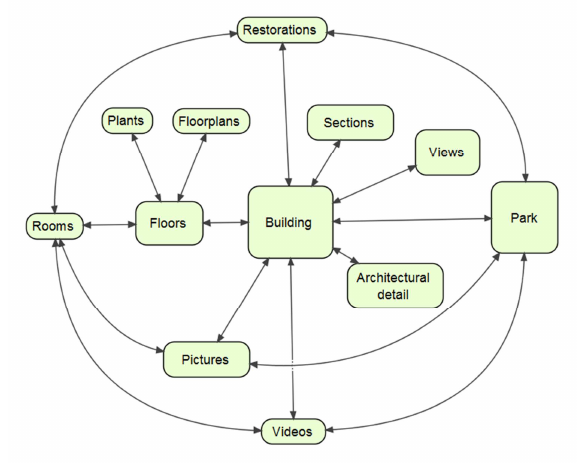
Figure 7. Conceptual model of the